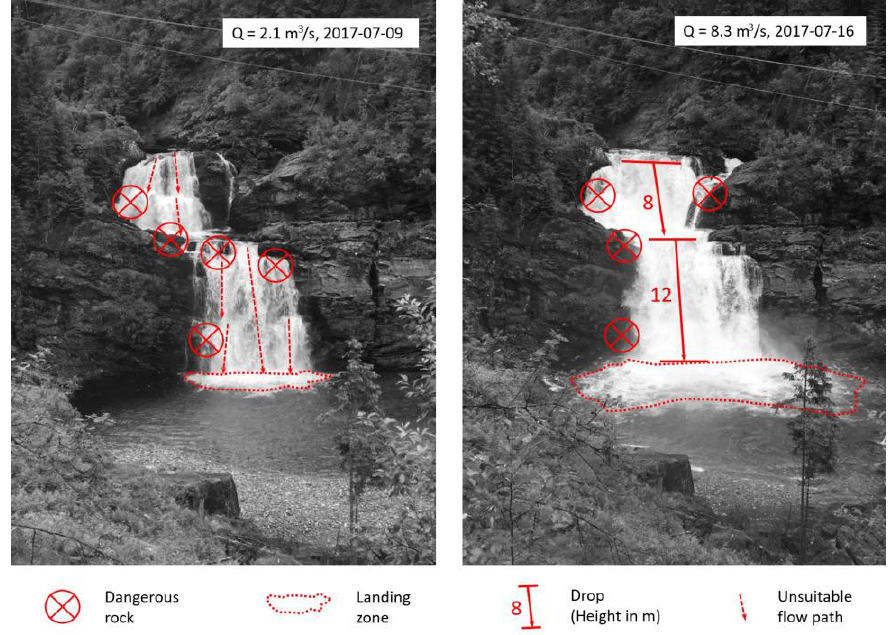
Figure 11. Double Drop at Kråkefoss at different flows in July 2017, for unsuitable low ( left ) and suitable ( right ) kayaking flows. Photos: Peggy Zinke.